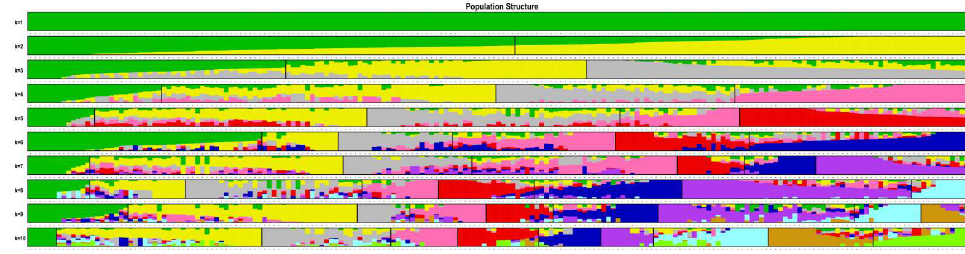
Fig 3. Pattern of variation among the 197 accessions based on 62,363SNPs. The x-axis showeddifferent accessions. The y-axis quantifiedthe membershipprobabilityof accessions belongingto different groups. Colors in each row represented structural